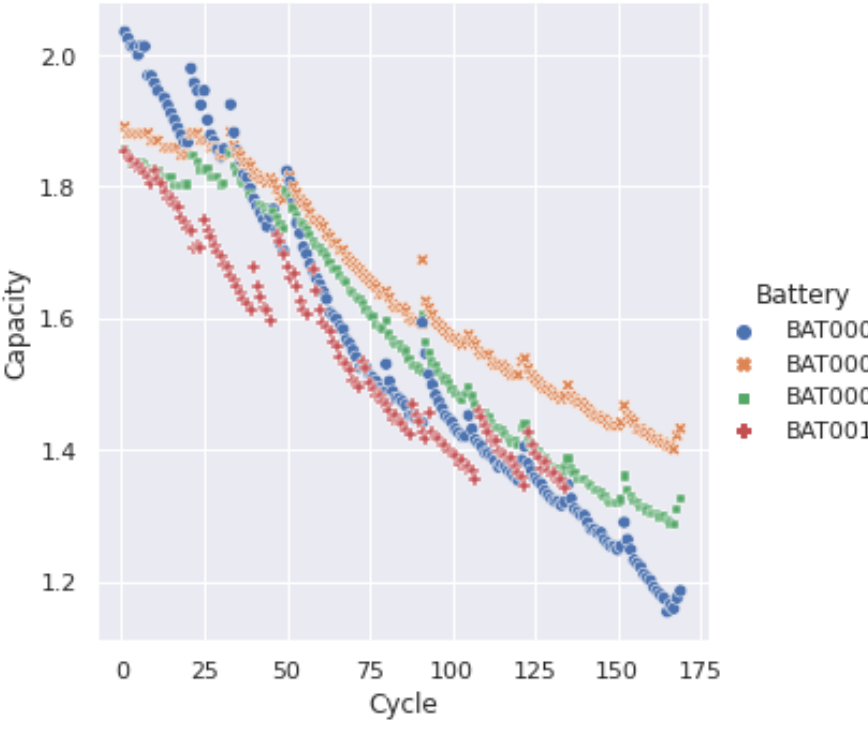
Figure 2. Different capacity behaviour from the same battery